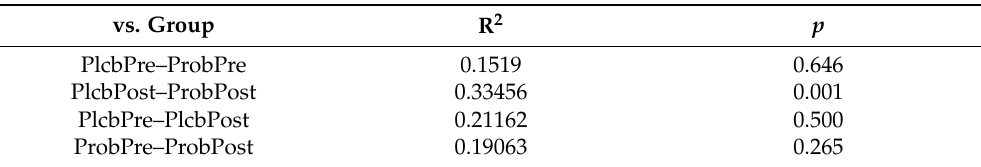
Figure 7. NMDS based on Bray − Curtis dissimilarity between the placebo and probiotic groups. Table 5. PERMANOVA analysis based on Bray − Curtis dissimilarity between the placebo and probiotic groups.